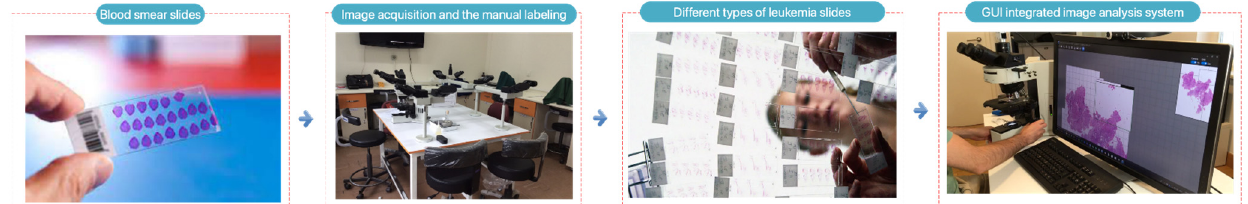
Figure 2. How to collect data for leukemia groups.